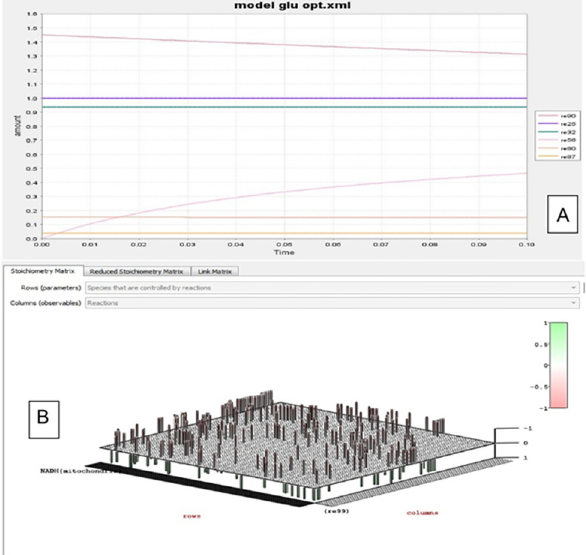
Fig 5. Uremia simulation. A plot showing concentration rates as a function of time which infers that all the reactions tend to obtain a constant rate of reaction as the slope becomes